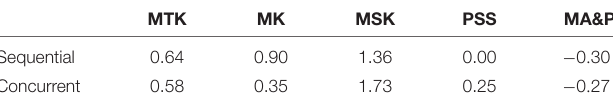
TABLE 2 | Longitudinal effect sizes (Hedges’ g av ) for both